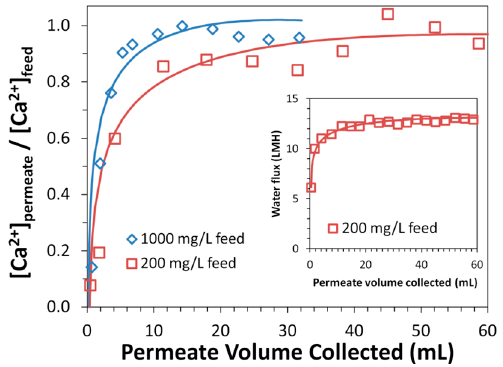
Figure 10. Normalized permeate concentration change during Ca 2+ pickup with N-SPVDF-PAA functionalized in convective flow mode. Inset shows the change in water flux for 200 mg/L CaCl 2 solution throughout experimental run. Feed solutions were passed through membranes using a dead-end filtration cell at 10.3 bar.